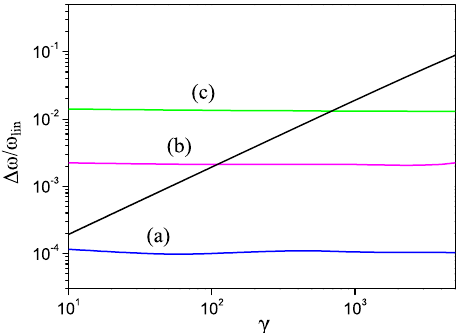
FIG. 6. Comparison between the nonlinear classical redshift and the quantum linear one (black curve): (a) a 0 ¼ 0 : 0081 , (b) a 0 ¼ 0 : 081 , and (c) a 0 ¼ 0 : 18 : .